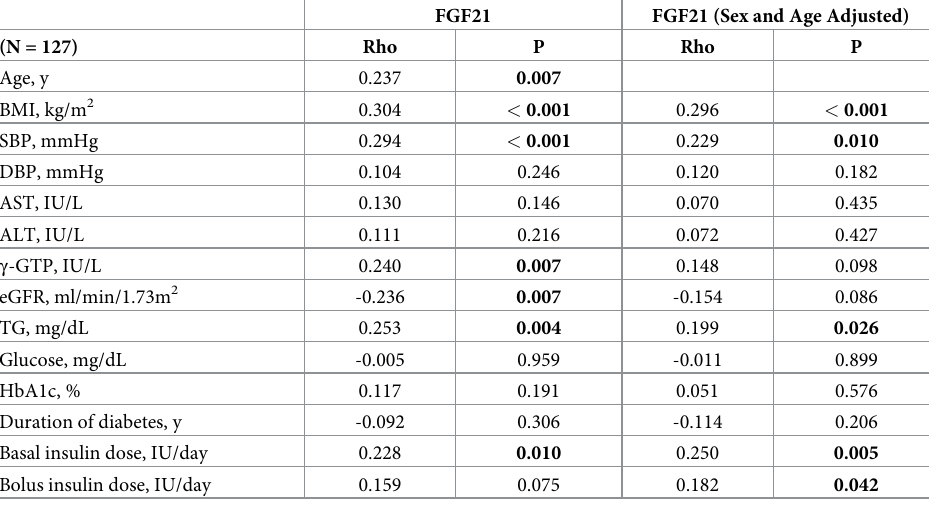
Data are the Spearman’s rank correlation coefficients. Boldface indicates significance.